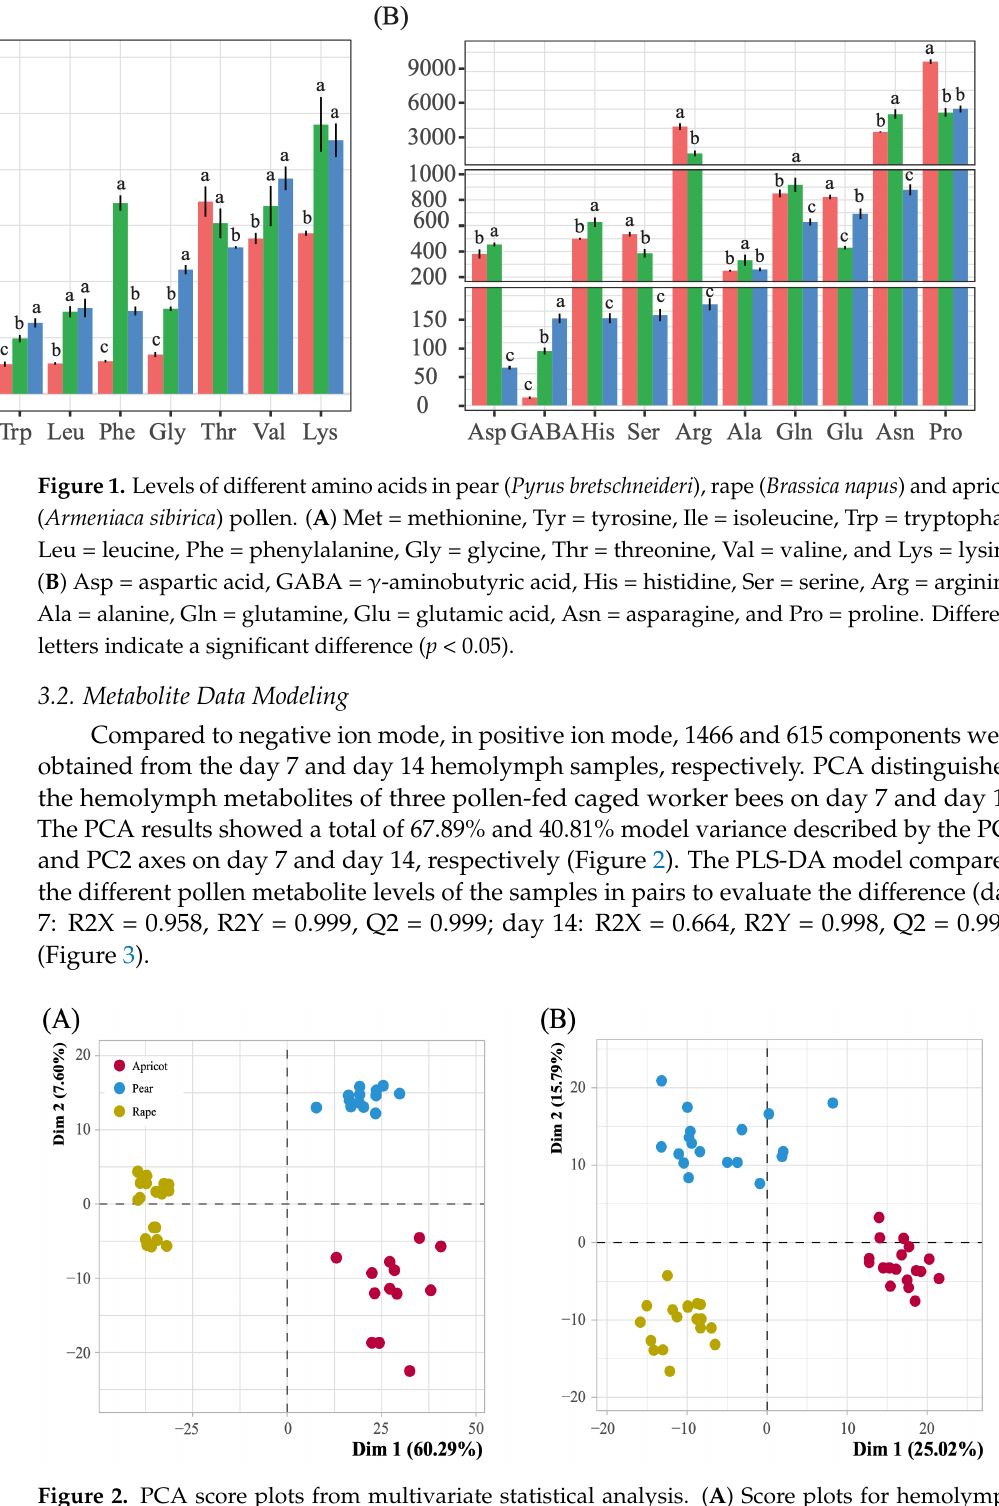
Figure 2. PCA score plots from multivariate statistical analysis. ( A ) Score plots for hemolymph me- tabolites after 7 days of bee pollen feeding (number of apricot, rape, and pear samples: 13, 17, and 13, respectively). ( B ) Score plots for hemolymph metabolites after 14 days of pollen feeding (number of apricot, rape, and pear samples: 17, 18, and 17, respectively).